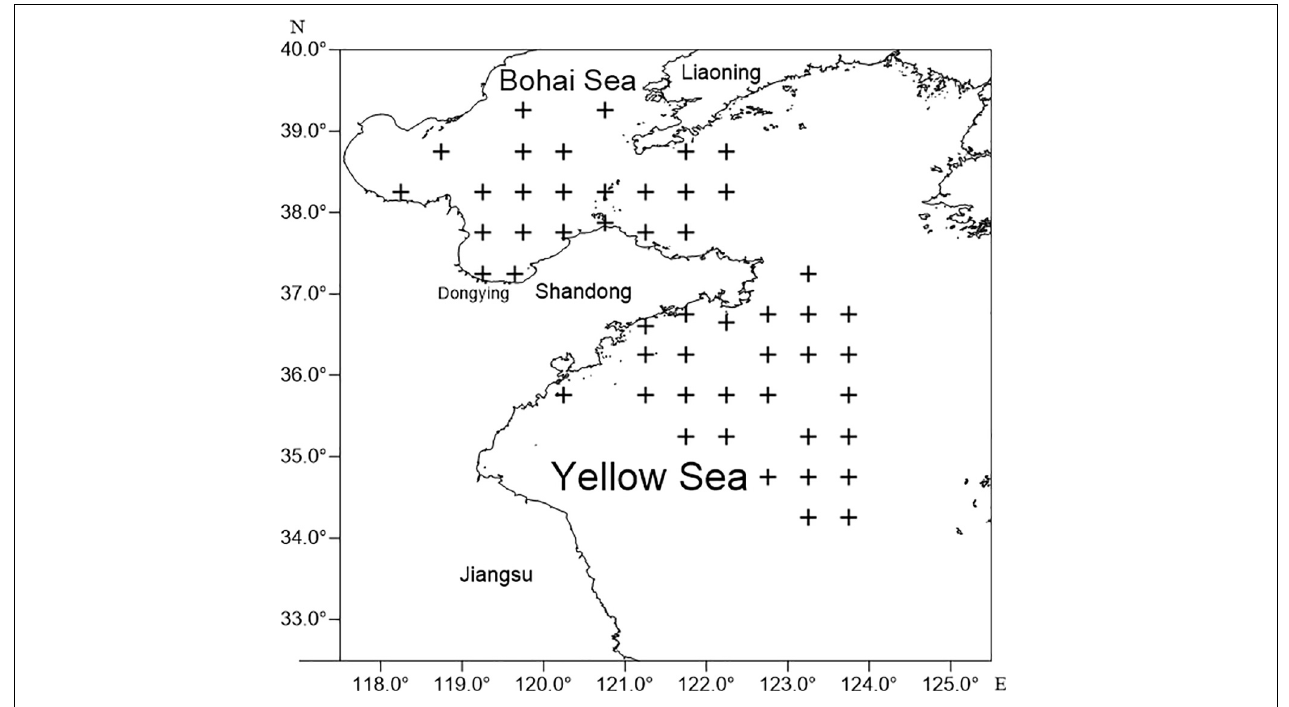
FIGURE 1 | Fishing areas, Bohai and Yellow Seas,